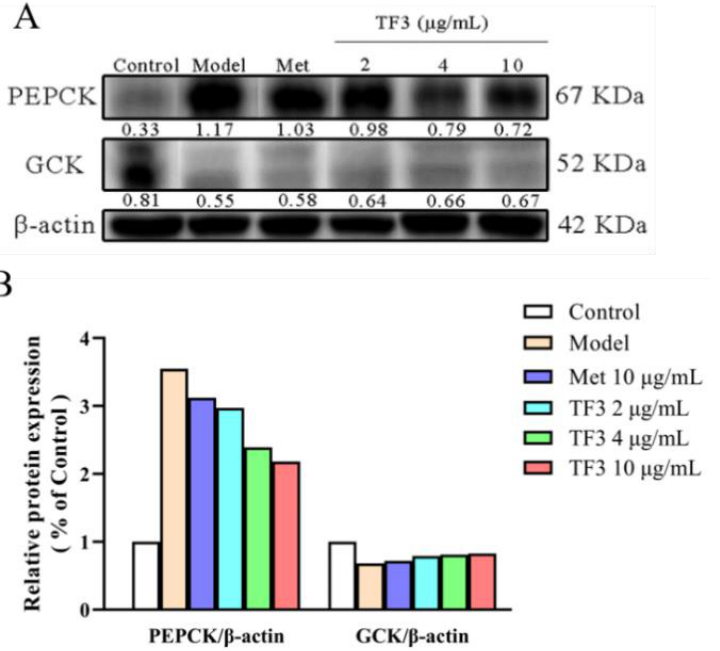
Figure 4. TF3 inhibited alloxan-induced hyperglycemia via regulating PEPCK and GCK expression. ( A ) Blot results and ( B ) relative protein expression. Control, water culture; model, water with 1 μM alloxan and 4% glucose culture for 24 h; TF3, water with different concentrations of TF3 (2, 4, 10 μg/mL) treating for 24 h after alloxan-treatment; Met, water with metformin hydrochloride (10 μg/mL) treating for 24 h after alloxan-treatment.